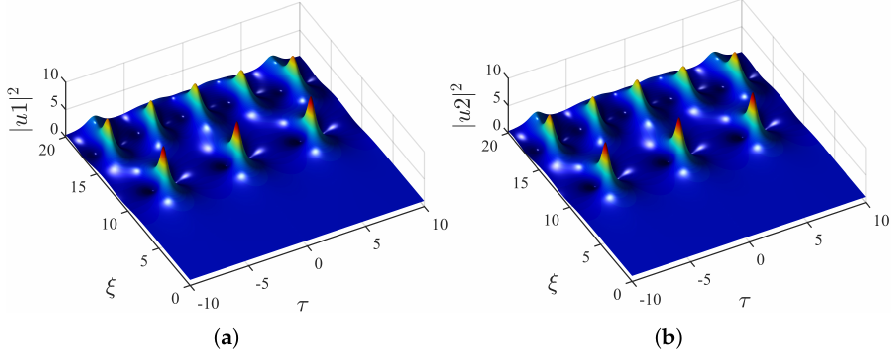
Figure 14. The evolution of the MI in the symmetric coupler with anomalous GVD ( σ = 1) in the bar ( a ) and cross ( b ) channels for equal amplitudes of the underlying CW state, A 1 = A 2 = 1, with perturbation parameters a 0 = 0.0001 and ω 0 = 1, in Equation (19). Other parameters are α = Γ = κ = 1 and ρ = χ =